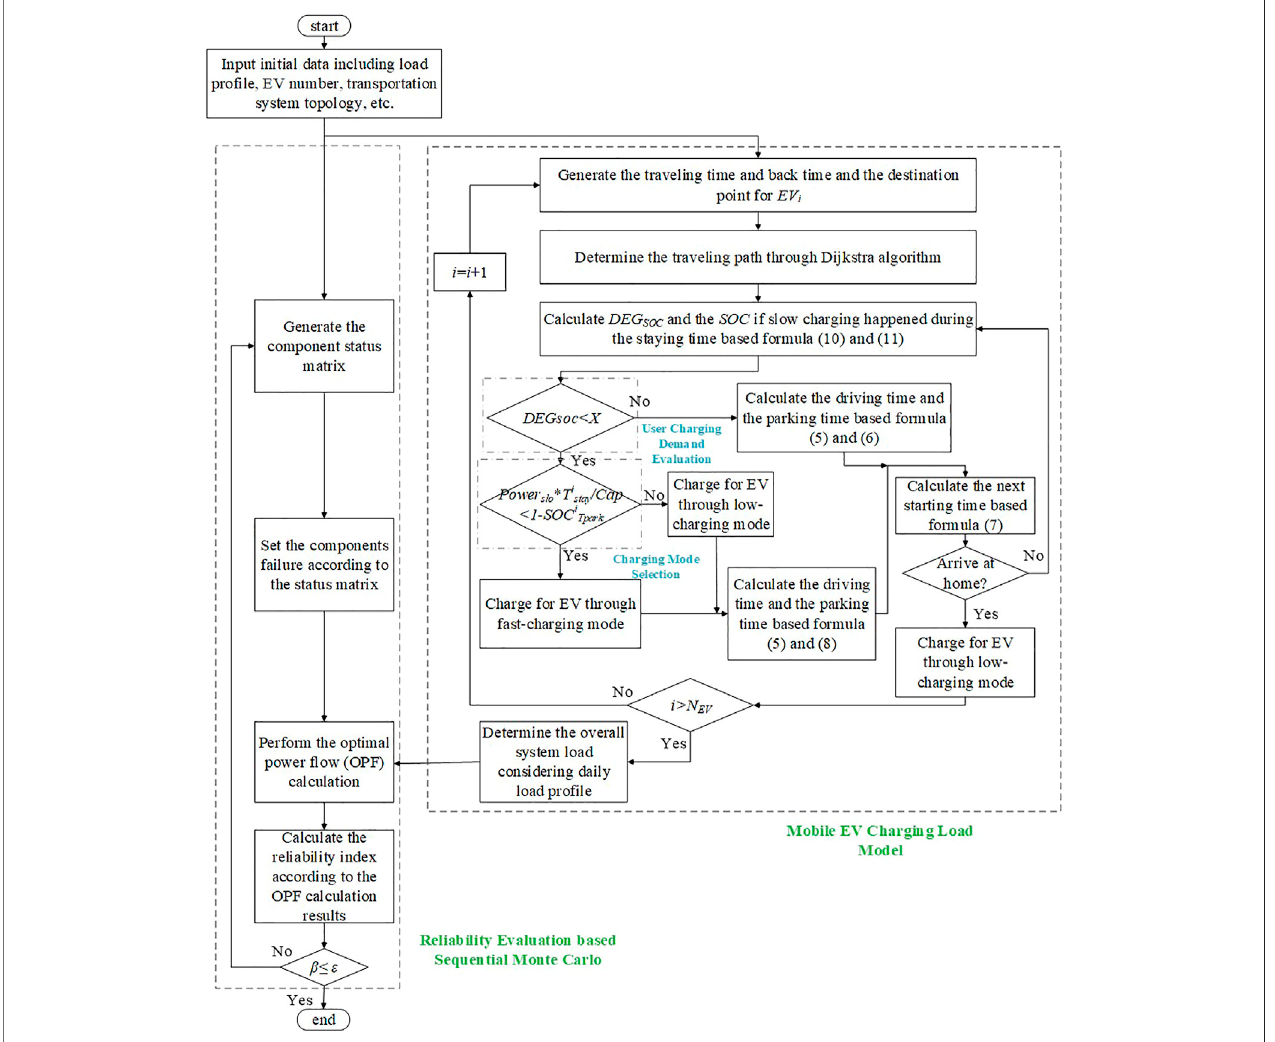
FIGURE 3 | Flowchart of reliability evaluation considering spatial-temporal EV charging load.